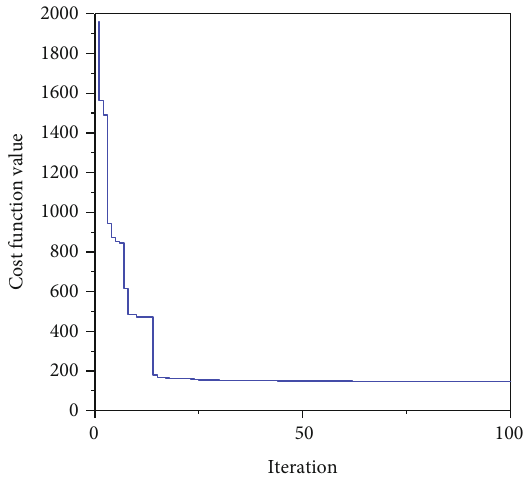
Figure 5: Evolving curve of the ABC